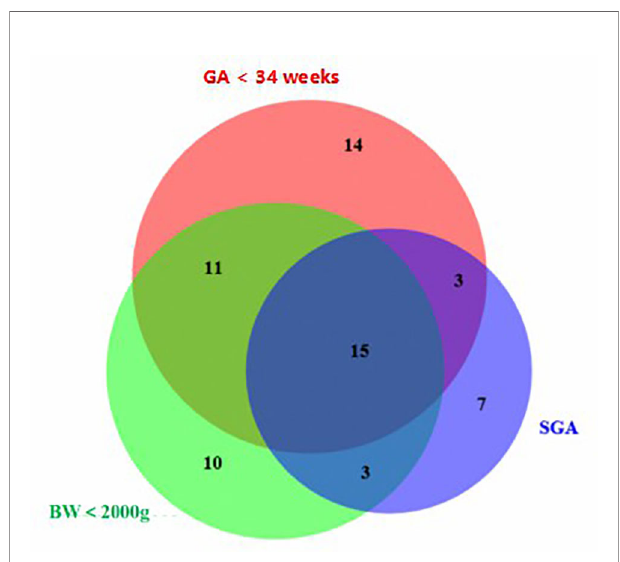
FIGURE 1 | Distribution of premature infants with GA <34 weeks, BW <2,000 g, andSGA and the proportion andoverlapping relationshipsbetween them. SGA , smallfor gestational age; GA , gestational age; BW , birth